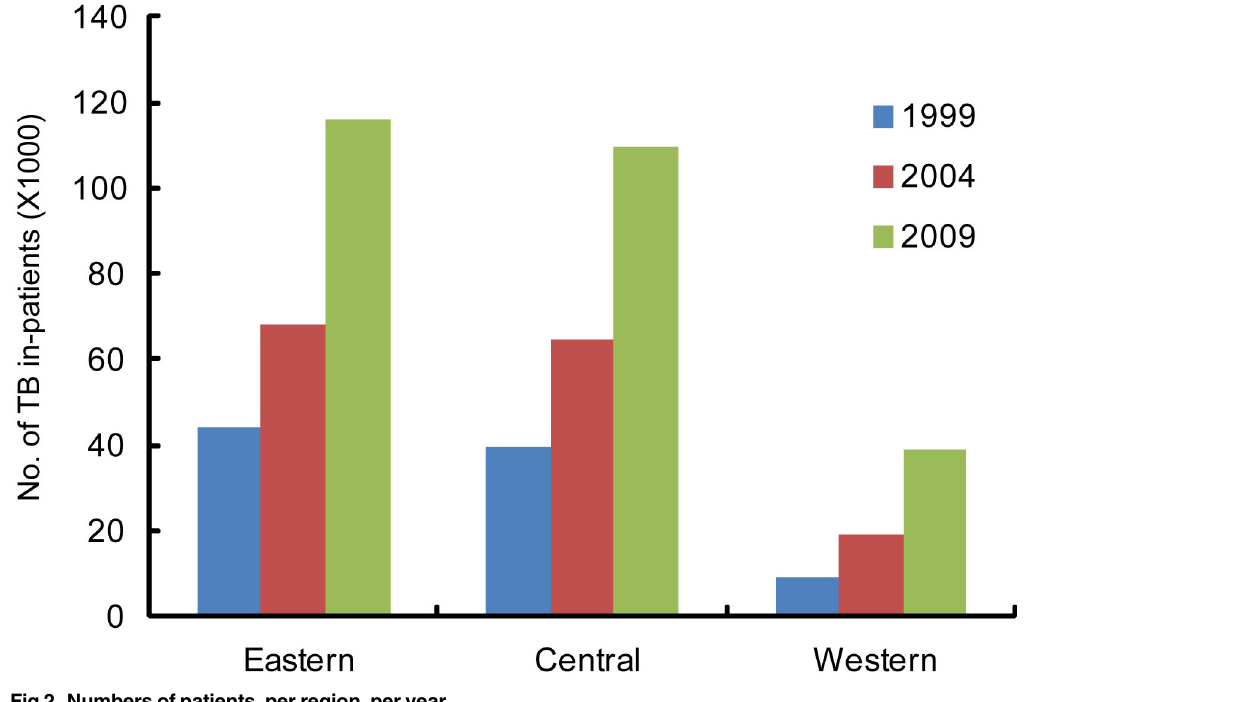
Fig 2. Numbers of patients, per region, per year.